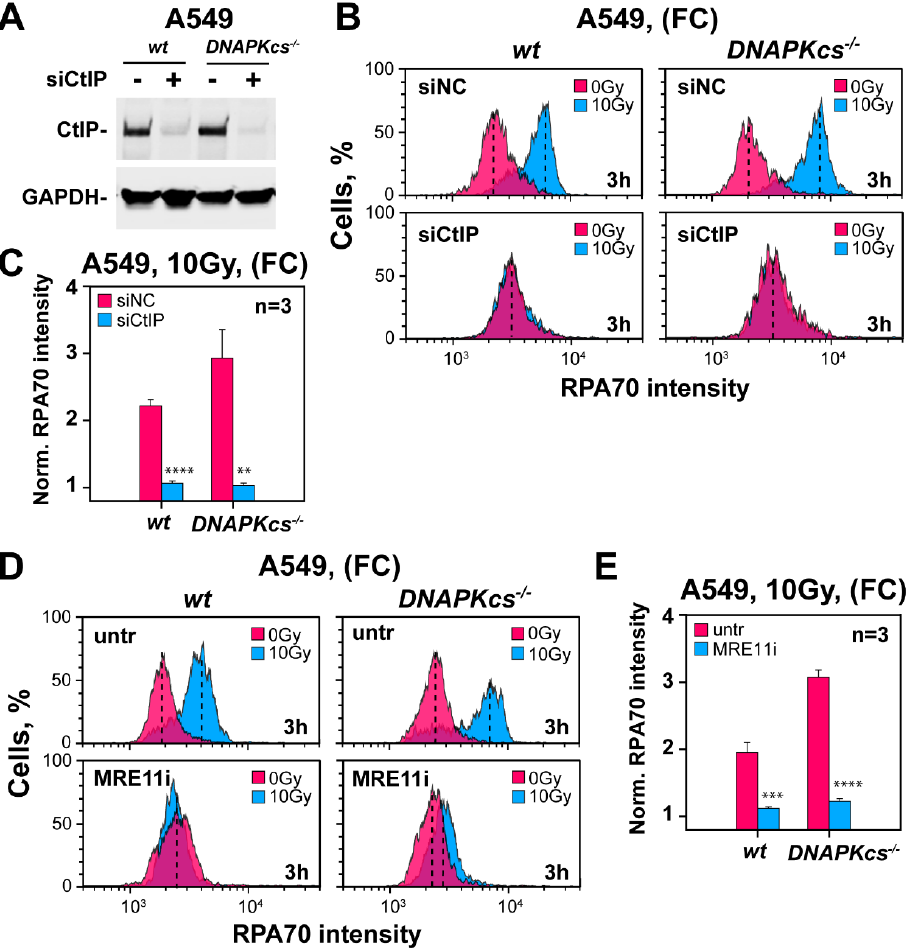
Figure 5. Resection in DNA-PKcs deficient and wild-type cells is entirely dependent on CtIP and MRE11. ( A ) Western blot analysis of CtIP levels in A549 wt and DNA-PKcs-/- cells after transfection with a siRNA targeting CtIP, or a non-specific control siRNA. ( B ) As in Figure 1D for A549 wt and DNA-PKcs -/- cells following CtIP depletion and exposure to 10 Gy of IR. ( C ) As in Figure 1E for the results shown in panel B. ( D ) As in panel B, for cells treated with a cocktail of the MRE11 inhibitors mirin and PFM01. ( E ) As in panel C for the results shown in panel D. ** indicates p < 0.01, *** indicates p < 0.001 and **** indicates p < 0.0001.